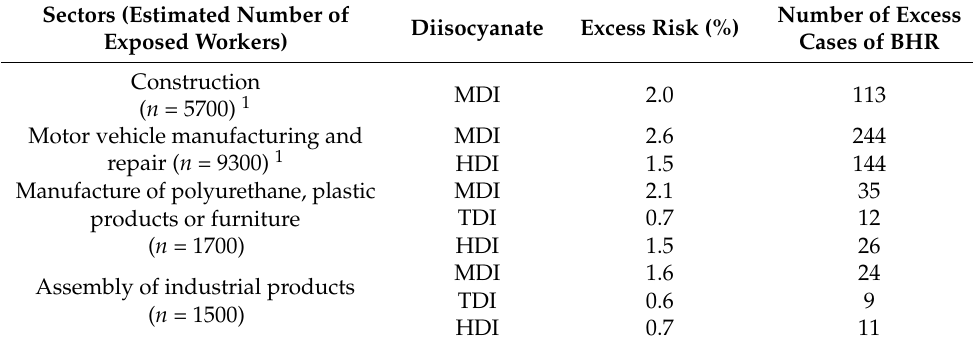
Table 6. Exposure reconstruction from biomonitoring data and estimated excess risk over a working life period of developing bronchial hyperresponsiveness (BHR) based on diisocyanate exposure in specific sectors in Finland. The excess risk estimations were based on RAC dose–responses for diisocyanates that cause